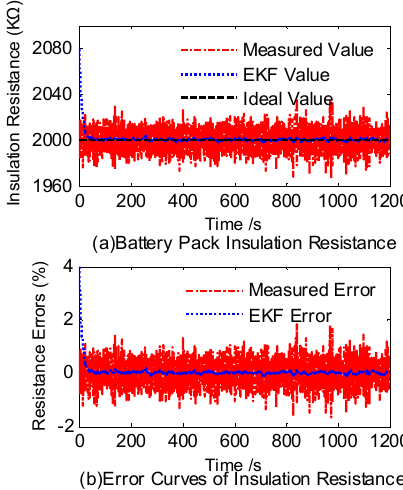
Figure 12. Comparison and error analysis of insulation resistances (with 2 M Ω resistance). ( a ) Comparison of insulation resistances; ( b ) Error analysis of insulation resistances.